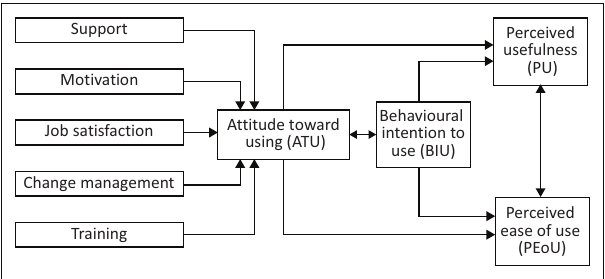
FIGURE 1: Modified technology acceptance